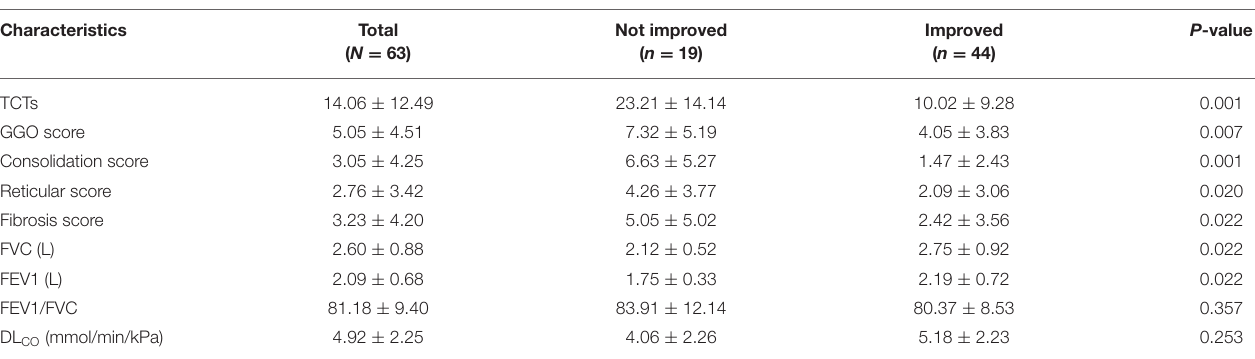
TABLE 2 | Pulmonary examinations for MDA5 +